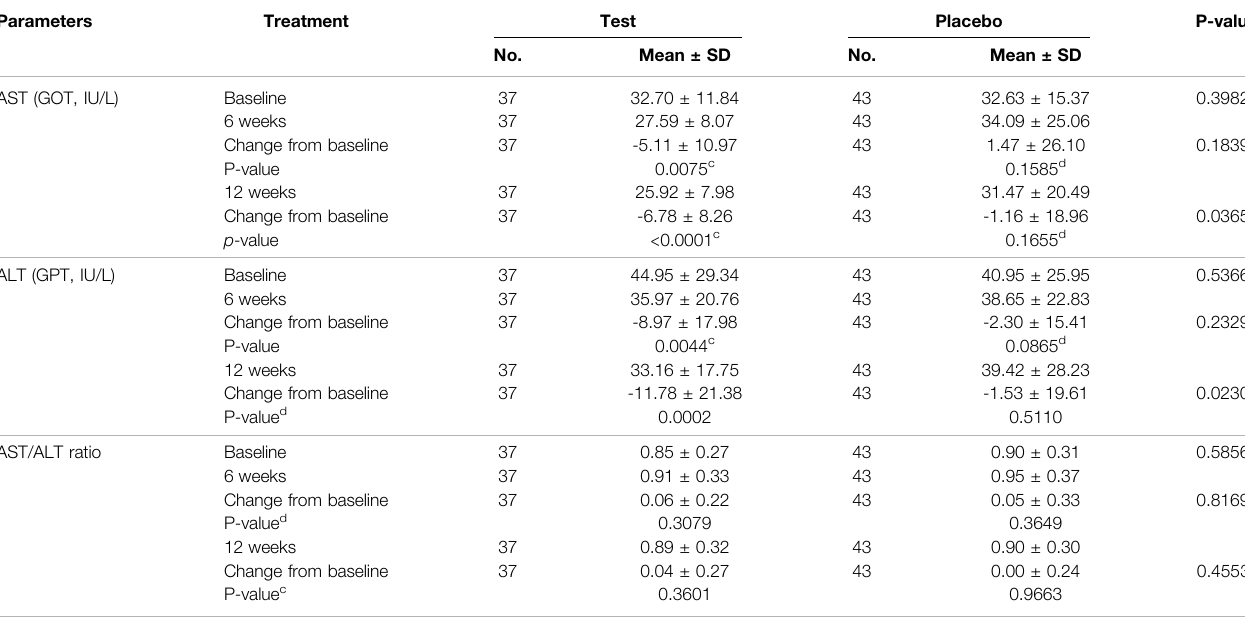
TABLE 4 | An analysis of levels of AST and ALT as well as the ratio of AST/ALT by visit (PP set). Parameters